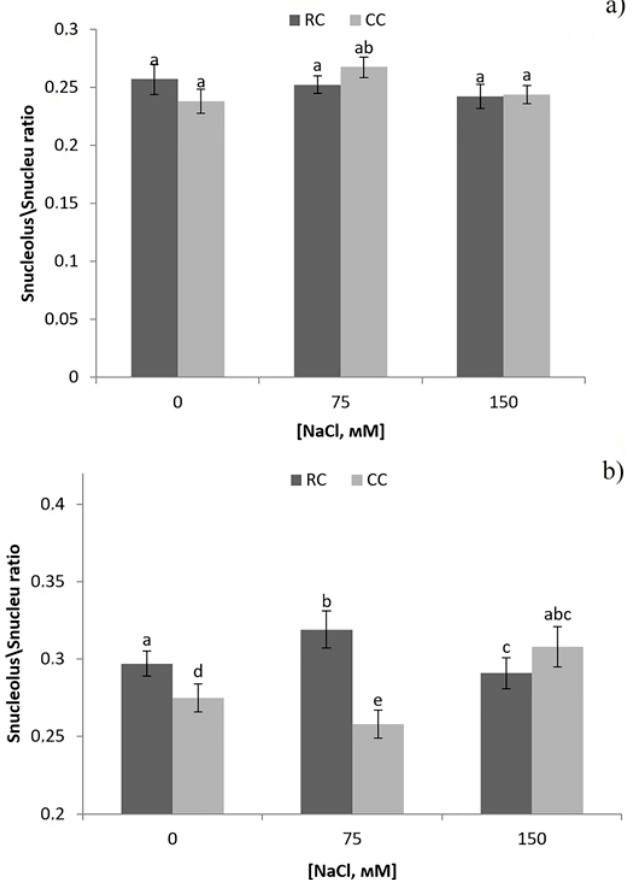
Figure 6. The effect of different NaCl concentrations in the nutrient medium for the induction of rhizogenesis on the S nucleolus /S nucleus of the YaLF tomato line ( a ) and cv Recordsmen ( b ), as shown by light microscopy. Abbreviations: RC—root cortex cell; CC—central cylinder cell. Means followed by the same letter are not significantly different at α = 0.05 according to Duncan’s multiple range test.